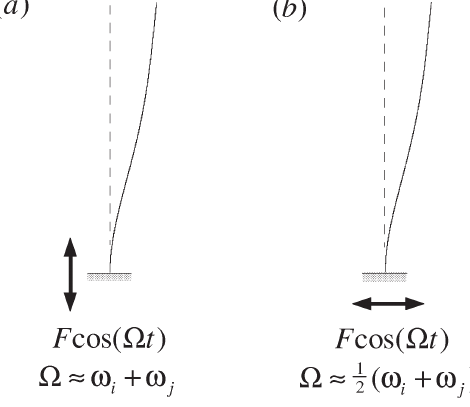
Fig. 1. A schematic of a cantilever beam under (a) combination para- metric resonance and (b) external subcombination resonance. two interacting modes. The modulation equations